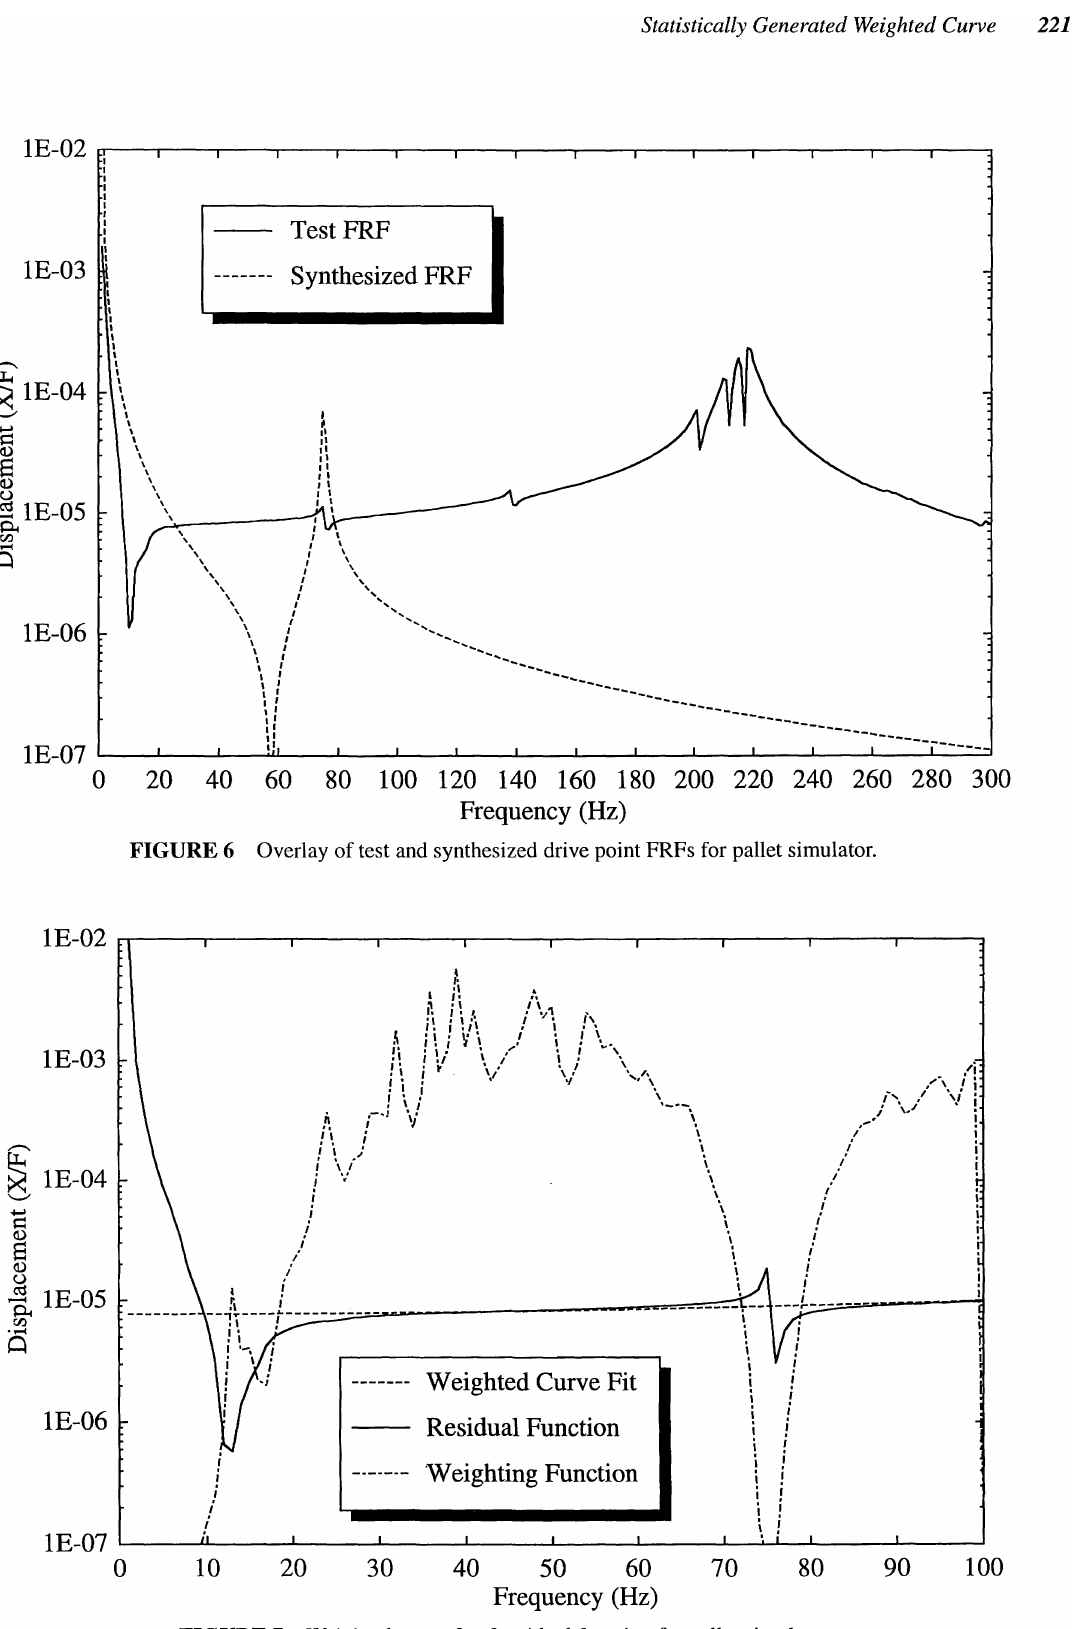
FIGURE 7 Weighted curve fit of residual function for pallet